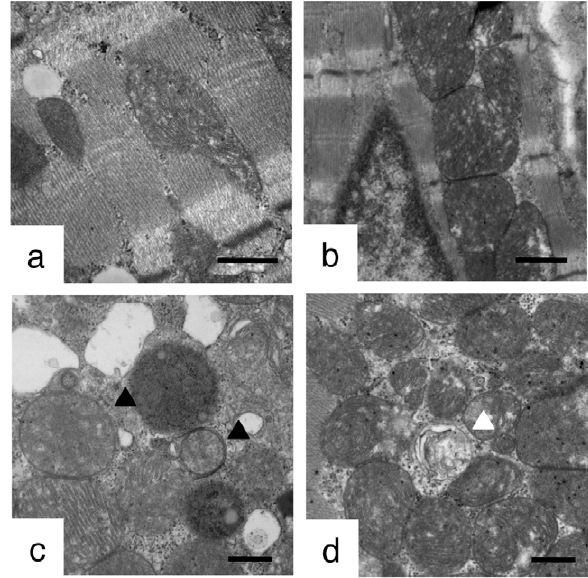
Figure 2. Electron microscopic analysis of the LPS-treated rat heart. Transmission electron micrographs of the rat heart treated with LPS (15 mg/kg, 3 h) with or without CoPPIX pretreatment (5 mg/kg, 24 h). Representative images in each group are shown: control (a), CoPPIX (b), LPS (c), LPS + CoPPIX (d). Bars, 500 nm. Black arrowheads indicate mitochondria swollen and/or surrounded by membranous structure. White arrowhead indicates mitochondria degraded within membranous